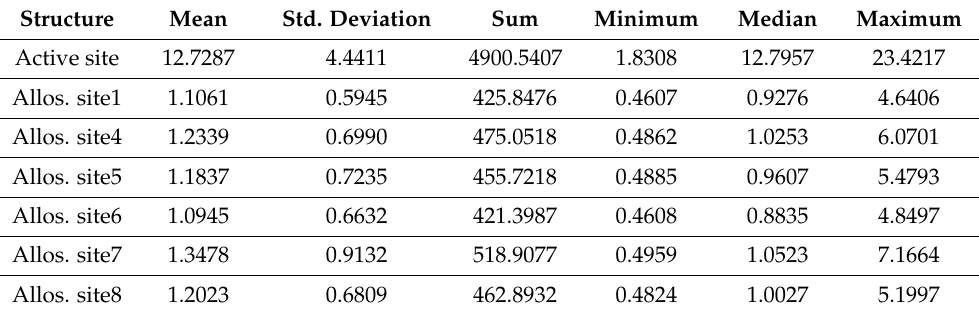
Figure 9. Per residue (a total of 385) fluctuation through all-atom root-mean-square fluctuation (RMSF/angstrom) scoring for compound 1 binding to several regions on BACE1. Allos. site represents the allosteric site and the definition for each site including the interacting residues is available in Figure 6. Table 4. Statistics of the RMSF (in Å) scores per residue. Std. represents standard and Allos. site represents the allosteric site and the definition for each site including the interaction residues is available in Figure 6.